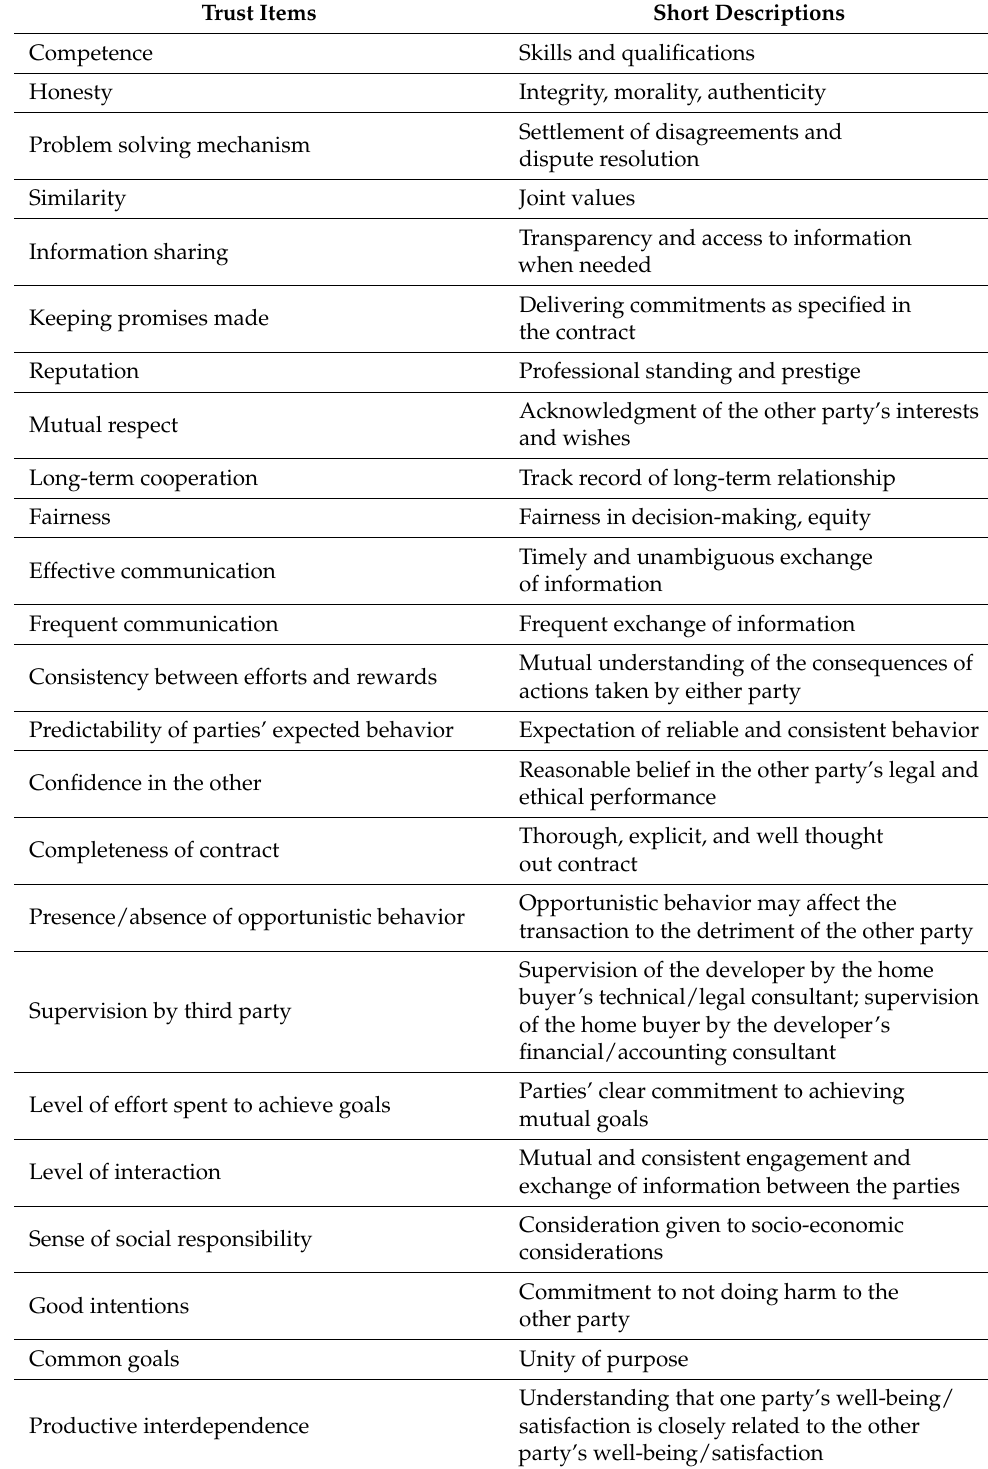
Table 3. Items of trust between home buyer and developer